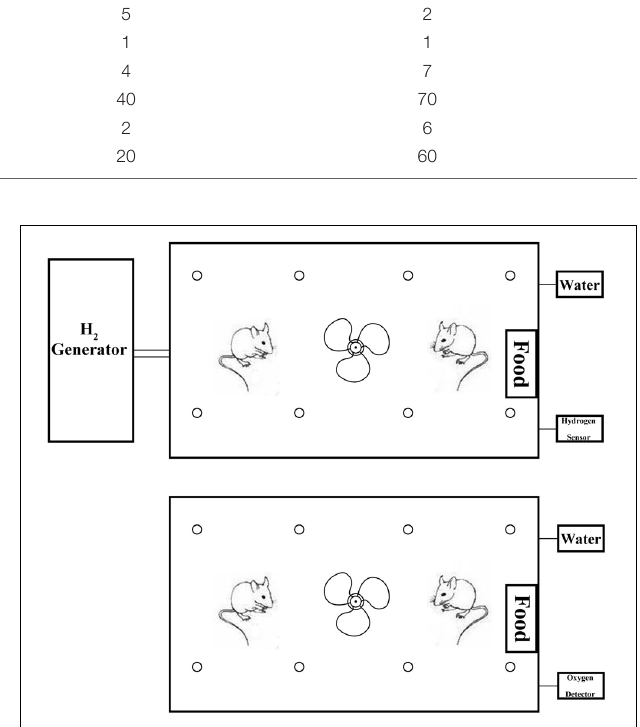
FIGURE 2 | The H 2 and air intake device for the rats. The fan in the ventilated box contributes to flowing of the air or H 2 . The box contains food, water, and bedding. Therefore, the rats could live in the box for a long